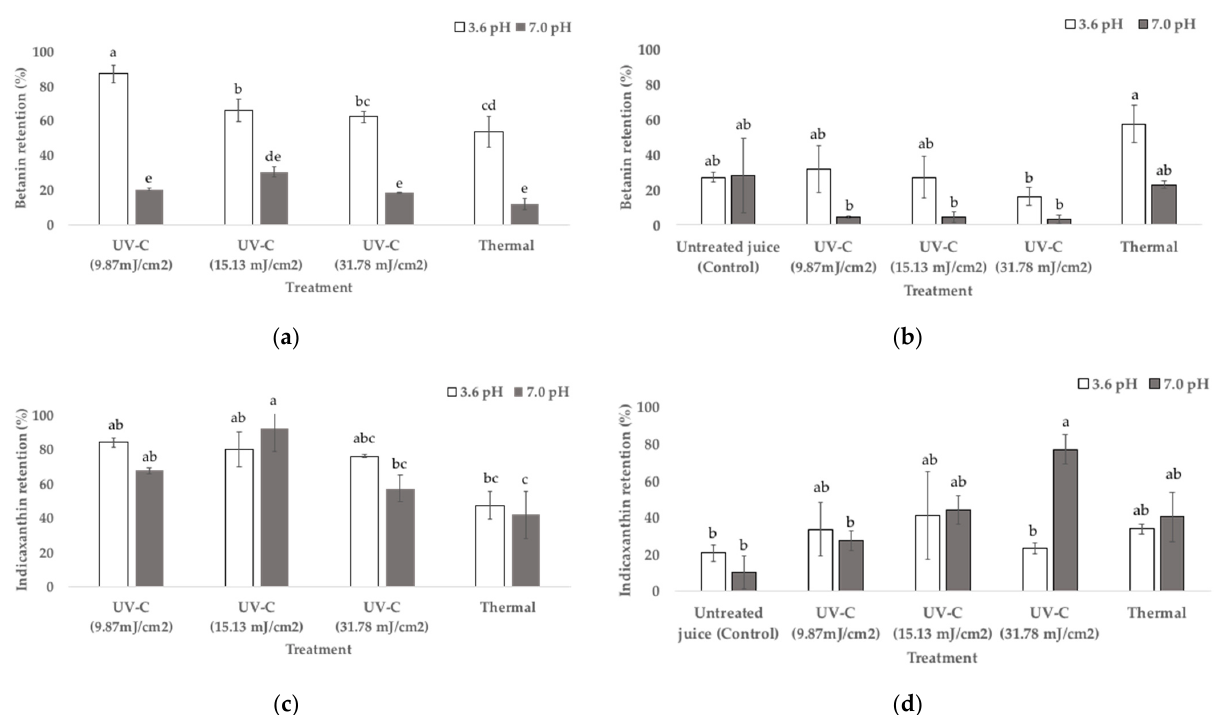
Figure 5. Effect of UV-C irradiation and thermal treatment (HTST or UHT) on betalain retention (%) of red prickly pear juice at pH 3.6 and 7 during storage: ( a ) betanin day 0 ( b ) betanin day 20 ( c ) indicaxanthin day 0 ( d ) indicaxanthin day 20. For each figure panel, different letter indicate significantly different mean ( p < 0.05), by Tukey’s test.